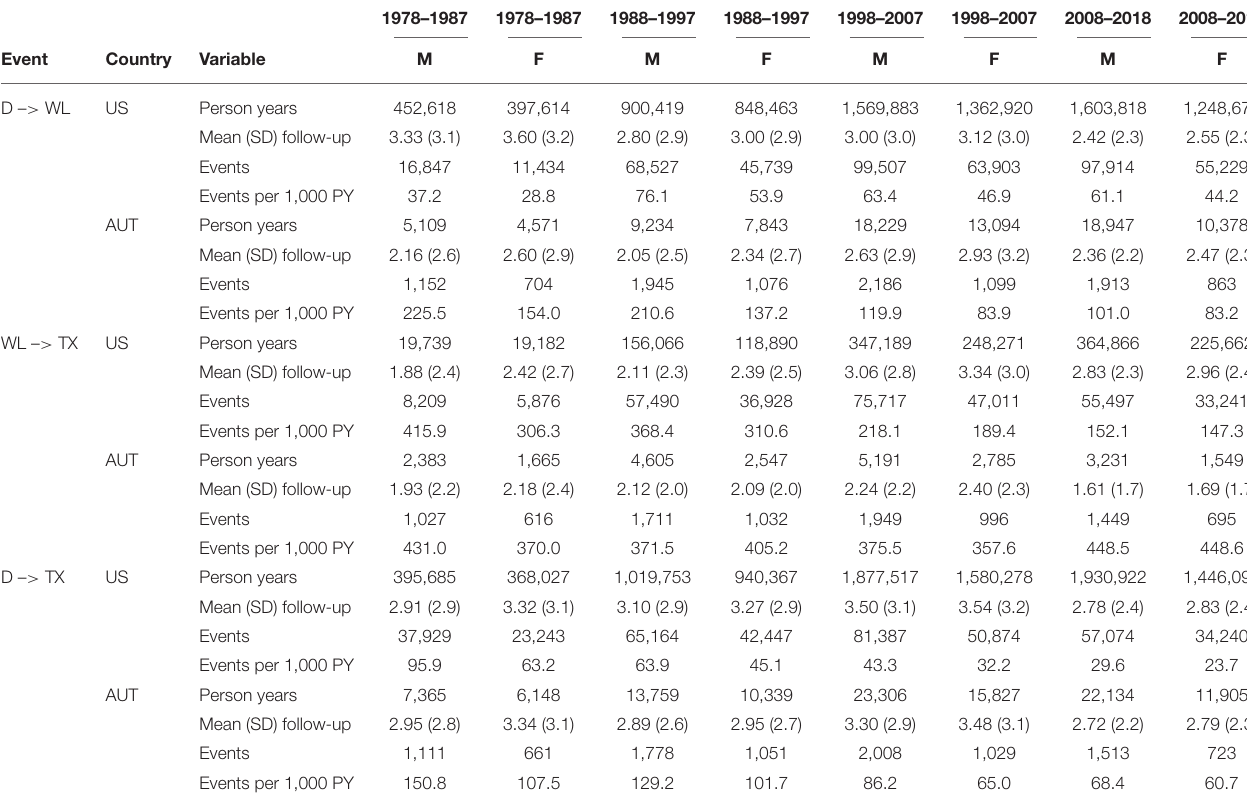
TABLE 3 | Crude time-to-event data per country, decade of dialysis initiation, and sex.